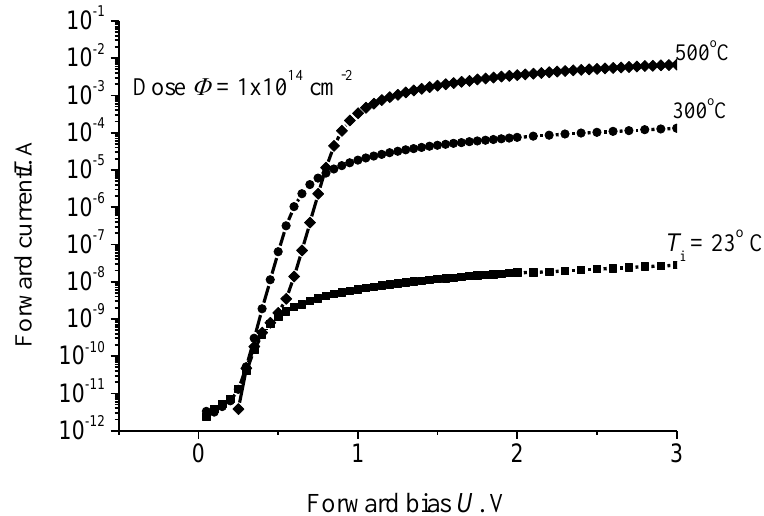
Figure 11. Forward current–voltage characteristics of the diodes upon their irradiation with 15 MeV protons at three different irradiation temperatures T i , the dose Φ = 1 × 10 14 cm −2 [48].